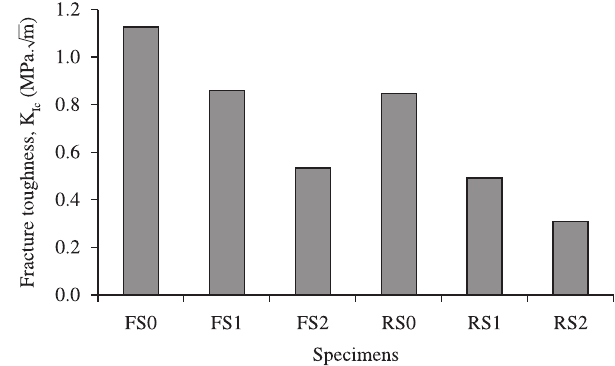
Figure 4. Load vs. CMOD test result of recycled sand textile reinforced polymer